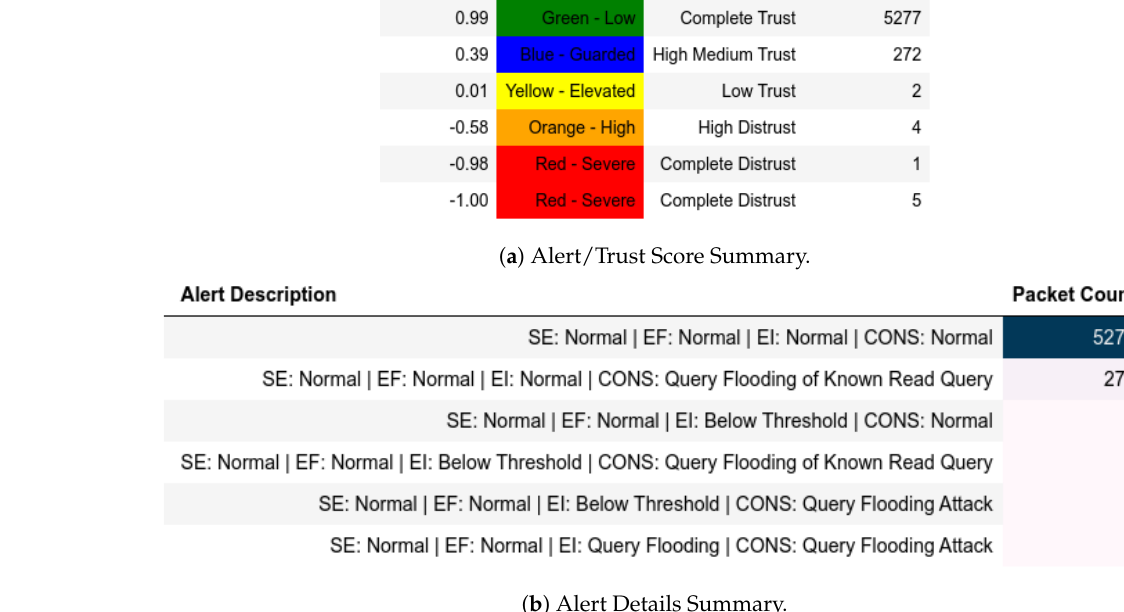
Figure 37. Client: ATENA H2020 dataset internal test with higher criticality